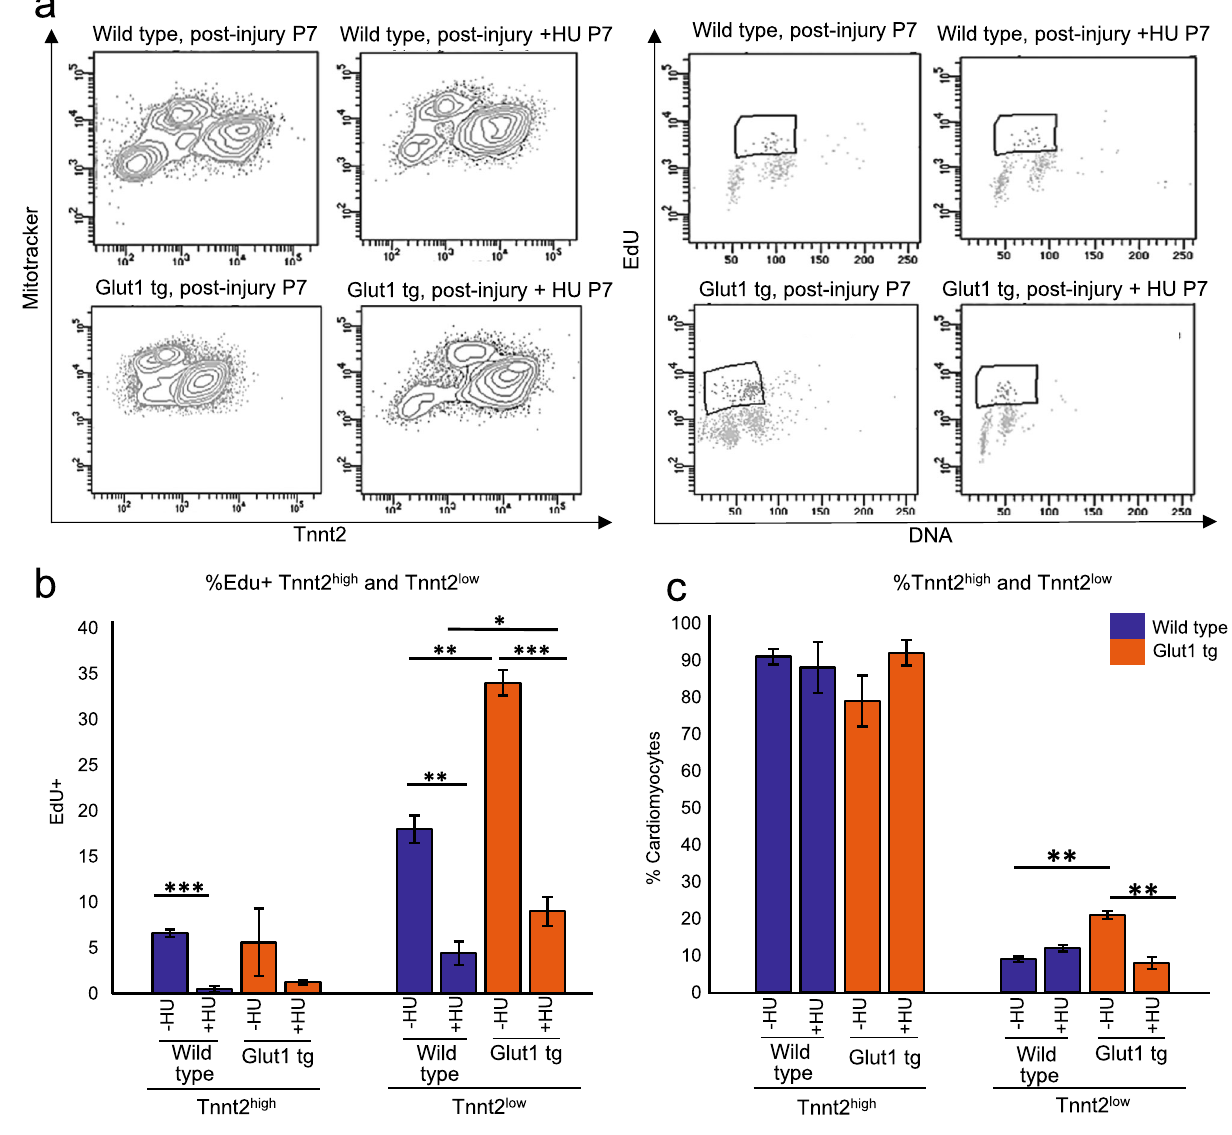
Figure 5. Impact of hydroxyurea on the proliferation of Tnnt2 low cardiomyocytes. ( a ) Representative contour plots (left) for Tnnt2 and Mitotracker and dot plots (right) for EdU and DNA content by flow cytometry analysis at P7. Wild type and Glut1 transgenic hearts were cryoinjured at P1 and treated with daily injection of HU or vehicle until the analysis at P7. ( b ) Quantification of %EdU positive cells in Tnnt2 high and Tnnt2 low cardiomyocytes in wild type and Glut1 transgenic hearts with or without HU treatment. Note that both Tnnt2 high and Tnnt2 low cardiomyocytes respond to HU treatment but that EdU incorporation of Tnnt2 low cardiomyocytes was drastically decreased by HU treatment. n = 4. *** p < 0.01. ( c ) Quantification of the Tnnt2 high and Tnnt2 low fractions of cardiomyocytes in wild type and Glut1 transgenic hearts with or without HU treatment. While Tnnt2 high or Tnnt2 low fractions was not influenced by HU in wild type heart, HU treatment significantly decreased the percentage of Tnnt2 low cardiomyocytes in Glut1 transgenic hearts. n = 4. ** p < 0.01. *** p <